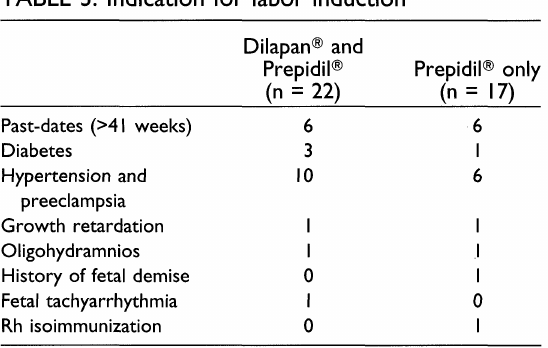
TABLE 3. Indication for labor induction